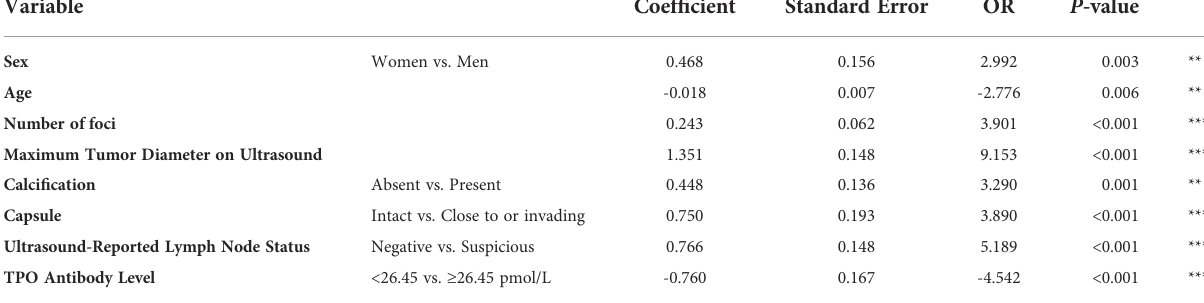
TABLE 4 Multivariate analysis of the predictive factors.